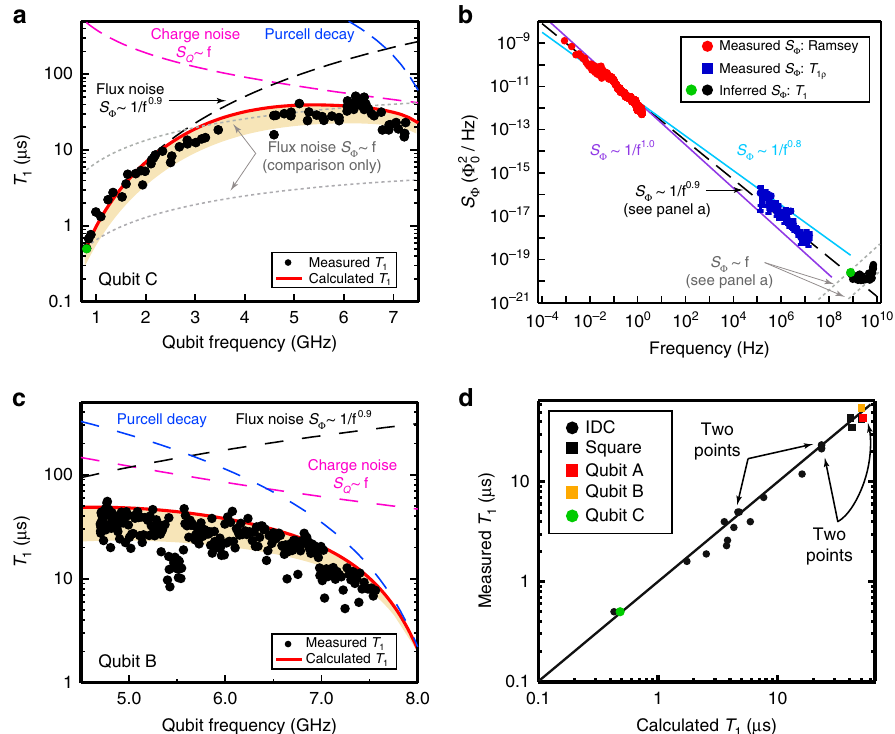
Figure 3 | T 1 variation with qubit frequency and noise modelling. ( a ) Energy-relaxation time T 1 versus qubit frequency for Qubit C ( C sh,C ¼ 9fF, I p,C ¼ 275nA, D c /2 p ¼ 0.82GHz) plotted with simulated T 1 values for individual (dashed lines) and aggregate (solid line) charge, flux and Purcell